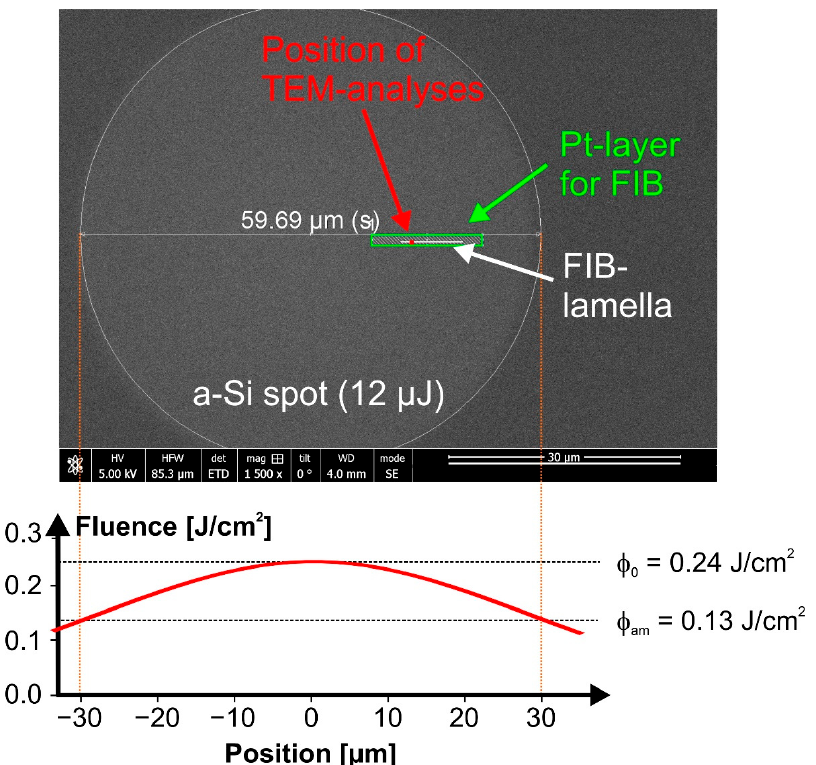
Figure 1. Top-view SEM image of an amorphous (a-Si) spot created by a single fs-laser pulse [ λ ~790 nm, τ = 30 fs, E p = 12 µJ / φ 0 = 0.24 J/cm 2 ] on the surface of a Si<111> wafer. Its diameter of 59.69 µm is indicated as an additional marking in white. The plot in the lower part visualizes the corresponding radially Gaussian laser beam profile through the center of the laser beam along with the peak fluence ( φ 0 ) and amorphization threshold fluence ( φ am ). The rectangular green box indicates the region of the post-irradiation deposition of a Pt-layer prior to the focused ion beam (FIB) preparation process. The horizontal white line within that box marks the orientation of the FIB lamella, while the red square indicates the position of transmission electron microscopy (TEM)/scanning transmission electron microscopy (STEM) imaging.